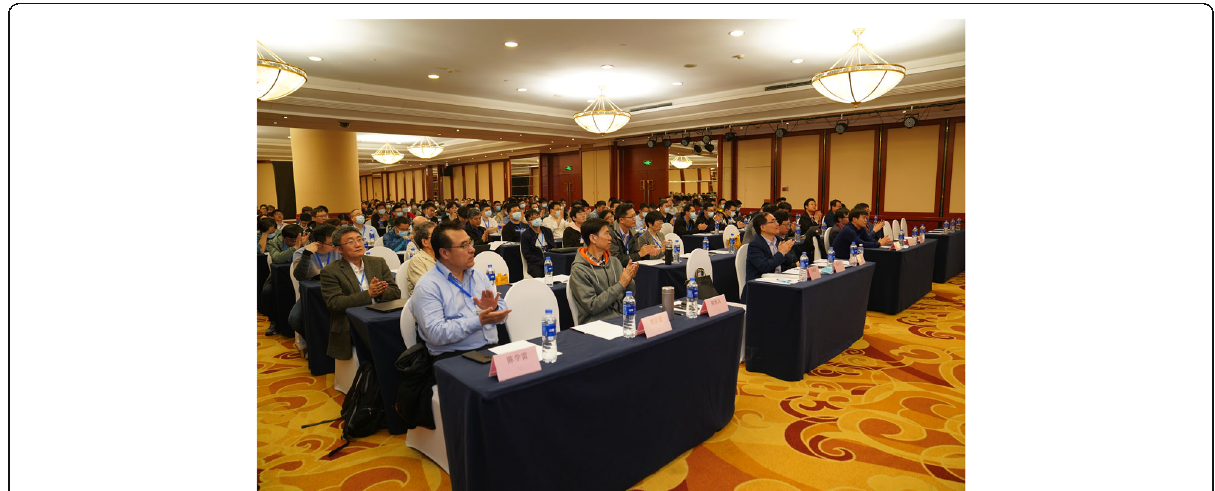
Fig. 6 Photo taken in the main conference